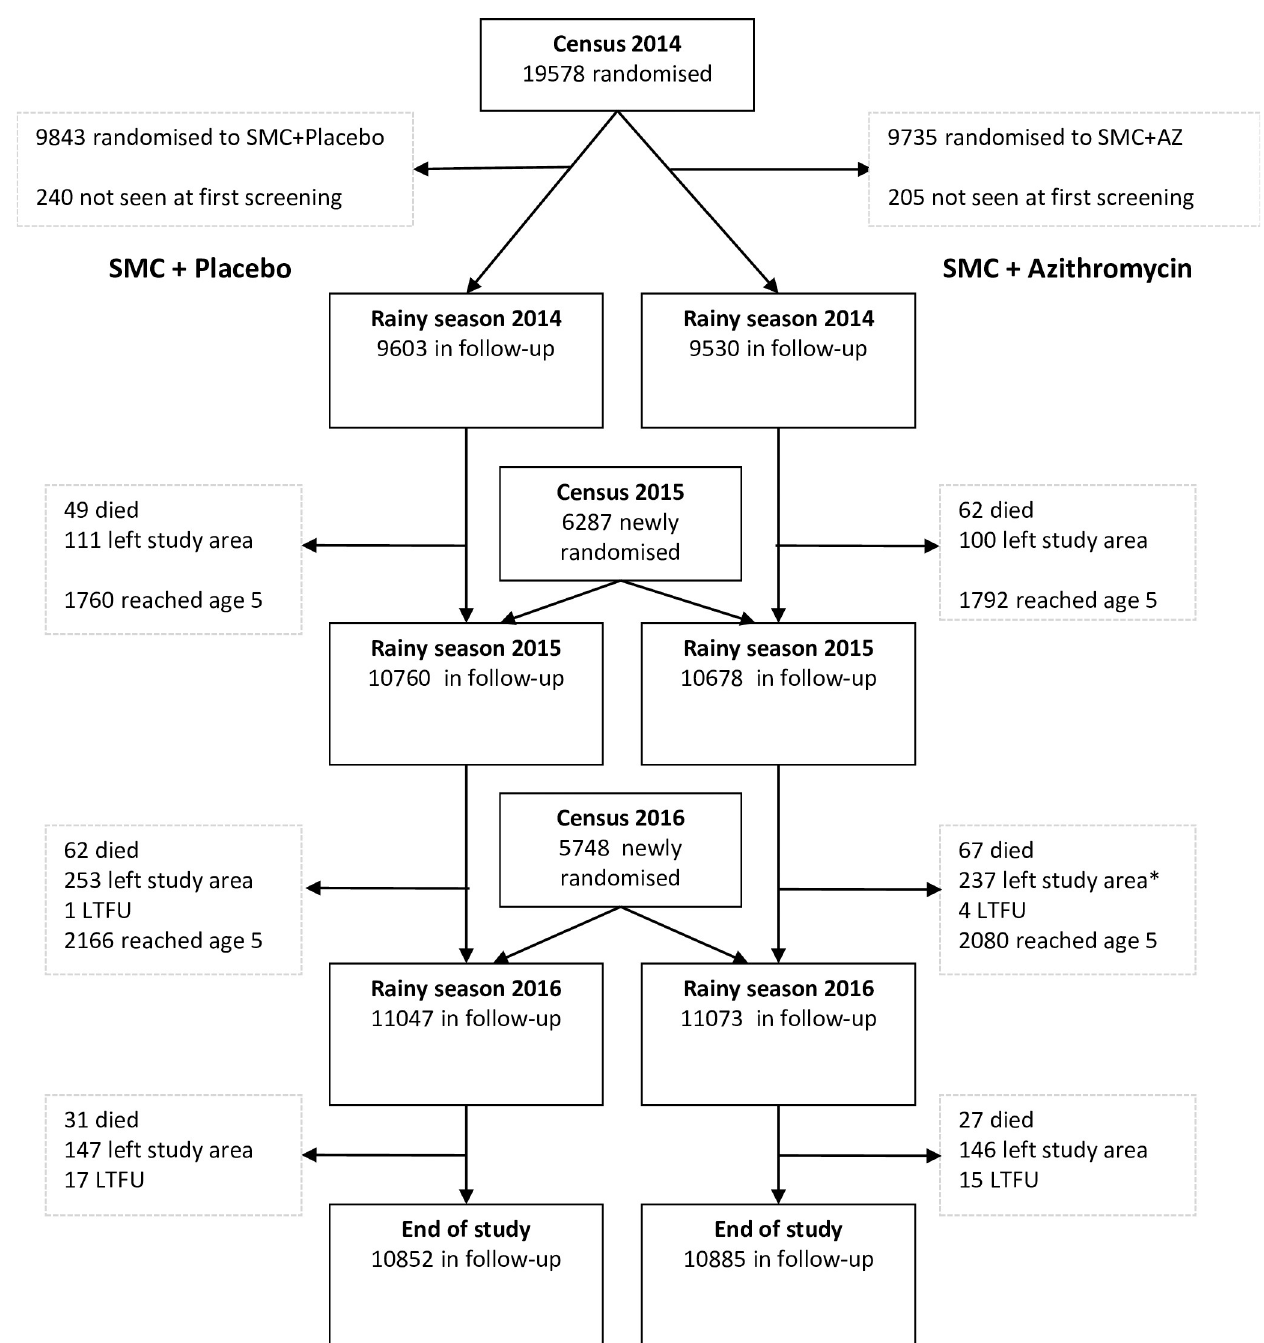
Fig 1. Screening, randomization, and